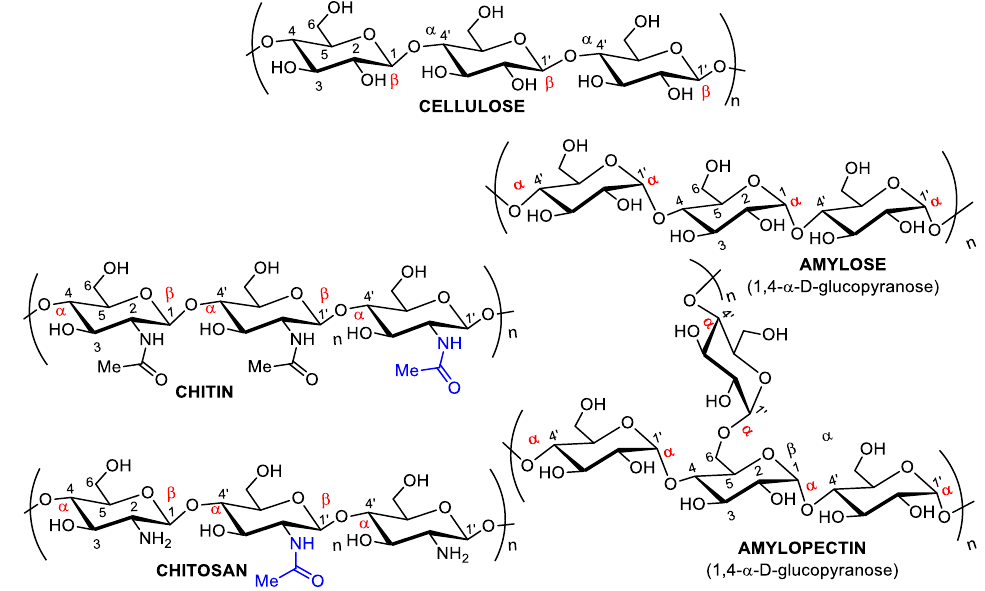
Figure 1. Major naturally abundant polysaccharides. Although cellulose, amylose, and amylopectin are D-glucose polymers, chitin and its deacetylated derivative, chitosan, are made up of D-glucosa- mine.